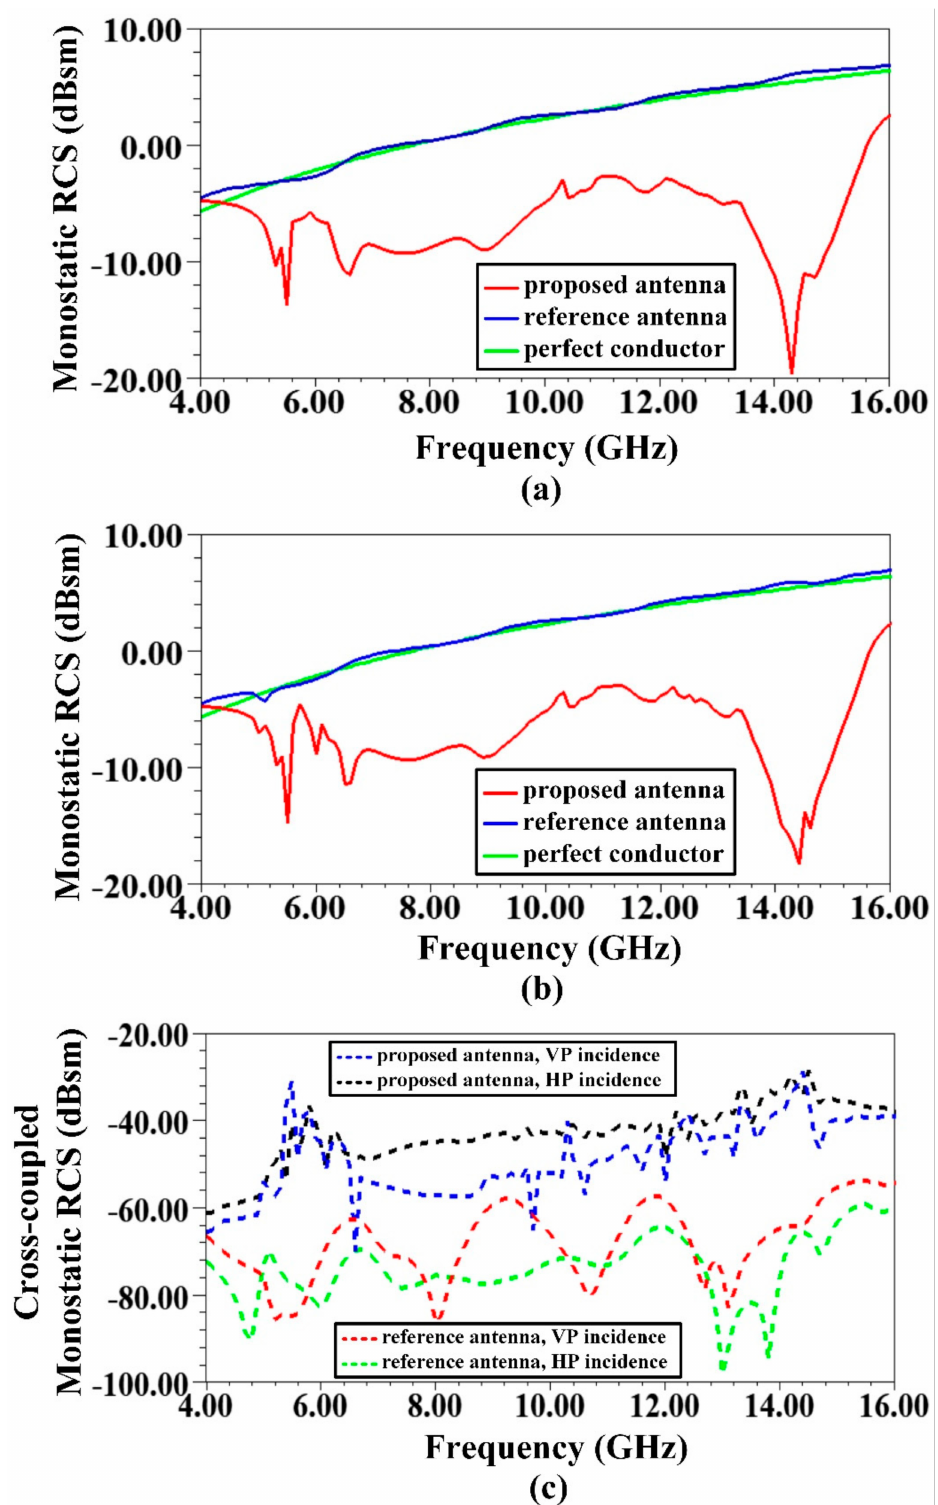
Figure 8. Frequency response of monostatic radar cross section (RCS) for ( a ) vertically polarized (VP) and ( b ) horizontally polarized (HP) wave incidences. ( c ) Cross-coupled monostatic RCS response for proposed and reference